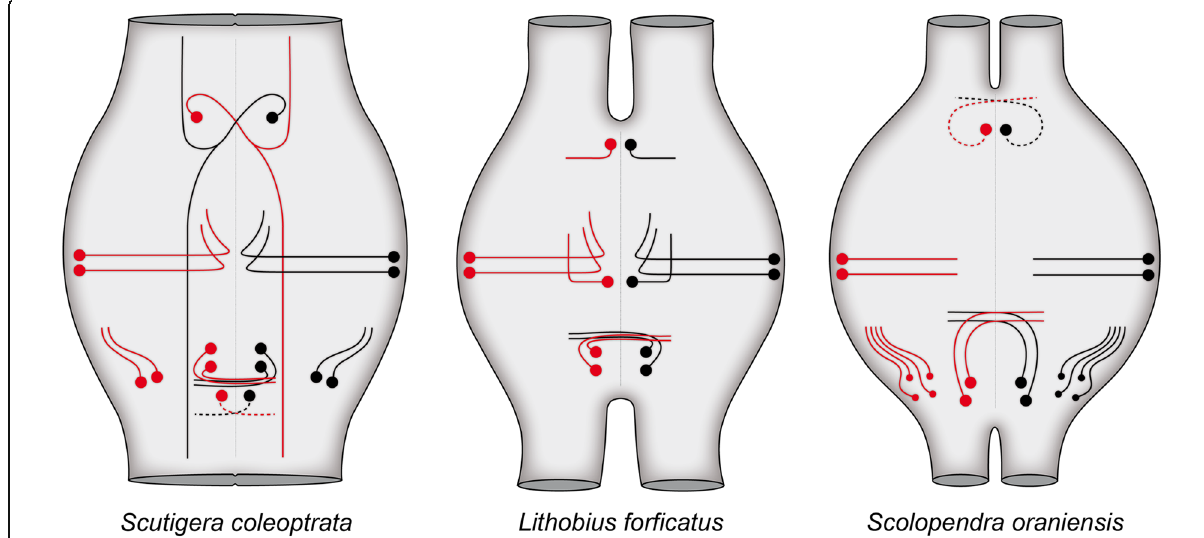
Fig. 6 Schematic representations of the morphologies of the serially homologous 5HT-ir neurons in the investigated species. Neurons and the associated projections are depicted in red for the left hemiganglion, and in black for the right